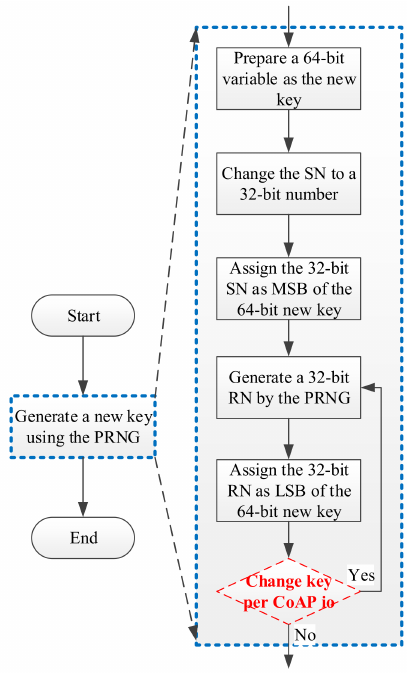
Figure 9. Execution flowchart of generating a new key in CoAP